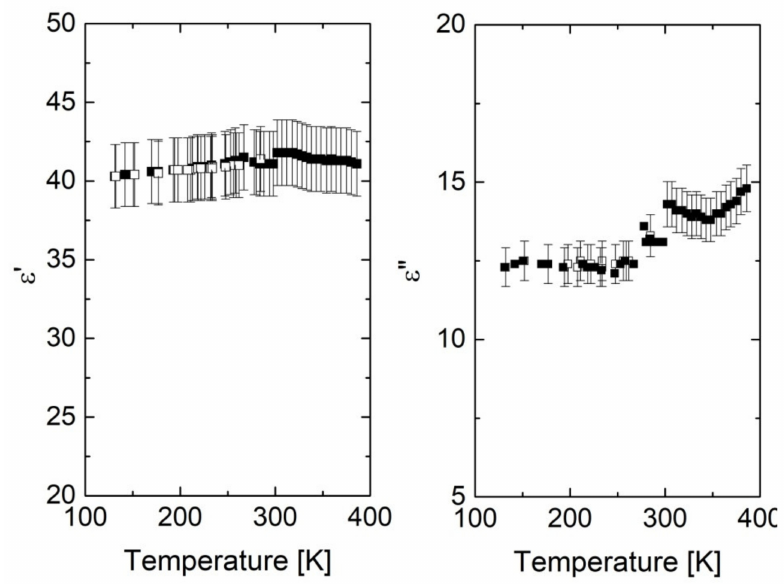
Figure 8. Temperature dependence of the complex dielectric permittivity for the nanocomposite fiber made of coPA_A + 7 wt% MWCNTs having diameter of 202 µ m (solid symbols results of measurements on heating, open on cooling). The measurement frequency was 30